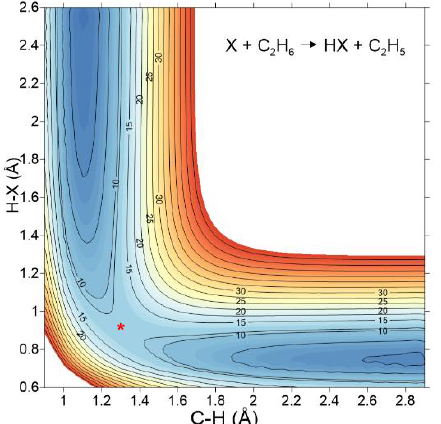
Figure 6. General equipotential contour plot for the X + C 2 H 6 reactions based on analytical PESs. Reactants and products appear clearly in the plot, while the saddle point is denoted as (*). In this case, we use as a model the reaction with hydrogen atom from Ref. [71].